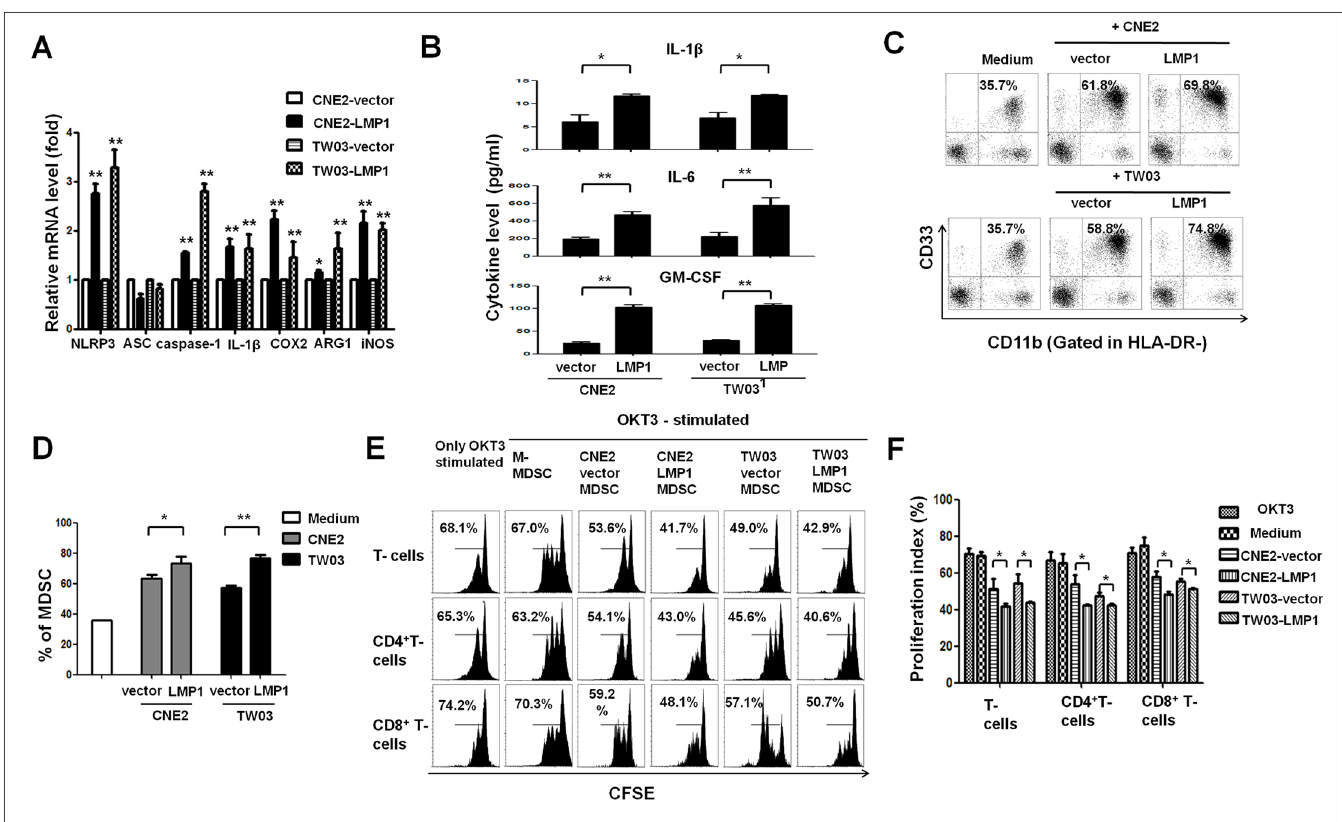
Fig 3. LMP1 promoted NPC-induced MDSC differentiation and the expression of MDSC-related molecules in NPC cells. CD33 + cells were isolated from healthyPBMCs using human CD33MicroBeadsand were co-cultured with NPC or NPC-LMP1 cells in a Transwell system for 48 h. The percentageof CD33 + CD11b + HLA-DR - MDSCs was measured by FACS staining.( A ) Expression of the NLRP3, ASC, caspase-1, IL-1 β , COX-2, Arg-1 and iNOS mRNAs was determined via real-time qRT-PCR, and the results were normalized againstGAPDH expression. ( B ) NPC cells, includingCNE2-vector, CNE2-LMP1, TW03-vector, and TW03-LMP1 cells, were cultured overnightfollowingstimulationwith LPS (0.1 μ g/mL) and ATP (5 mM, 30 min) or no stimulation.Then, the culture supernatantswere collected,and the concentrations of IL-1 β , IL-6 and GM-CSF were measuredby ELISA. ( C ) Representative density plots are shown as the CD33 + CD11b + cells in the HLA-DR - gate inducedby NPC or NPC-LMP1 cells in different combinations. Representative data from 1 of 5 experiments are presented. ( D ) Statistical analysisof the percentage of MDSCs mediatedby NPC cells in different combinations. CFSE-labeledPBMCs were co-cultured with M-MDSCs, CNE2-vector-MDSCs, CNE2-LMP1-MDSCs, TW03-vector-MDSCs or TW03-LMP1-MDSCs at a ratio of 1:1 in OKT3-coated 96-wellplates. After 3 days, the cells were collected,stained with anti-human mAbs against CD4 and CD8 and quantifiedby flow cytometry. Representative FACS density plots ( E ) and the statistical data ( F ) showedthat the proliferation of PBMCs and CD4 + and CD8 + T cells was markedly suppressedby CNE2-LMP1-MDSCs or TW03-LMP1-MDSCs comparedwith the effects of CNE2-vector-MDSCs or TW03-vector-MDSCs. Data are presented as the means ± SEM of representative experiments performed in triplicate. * P < 0.05, ** P < 0.01 comparedwith the control treatment.